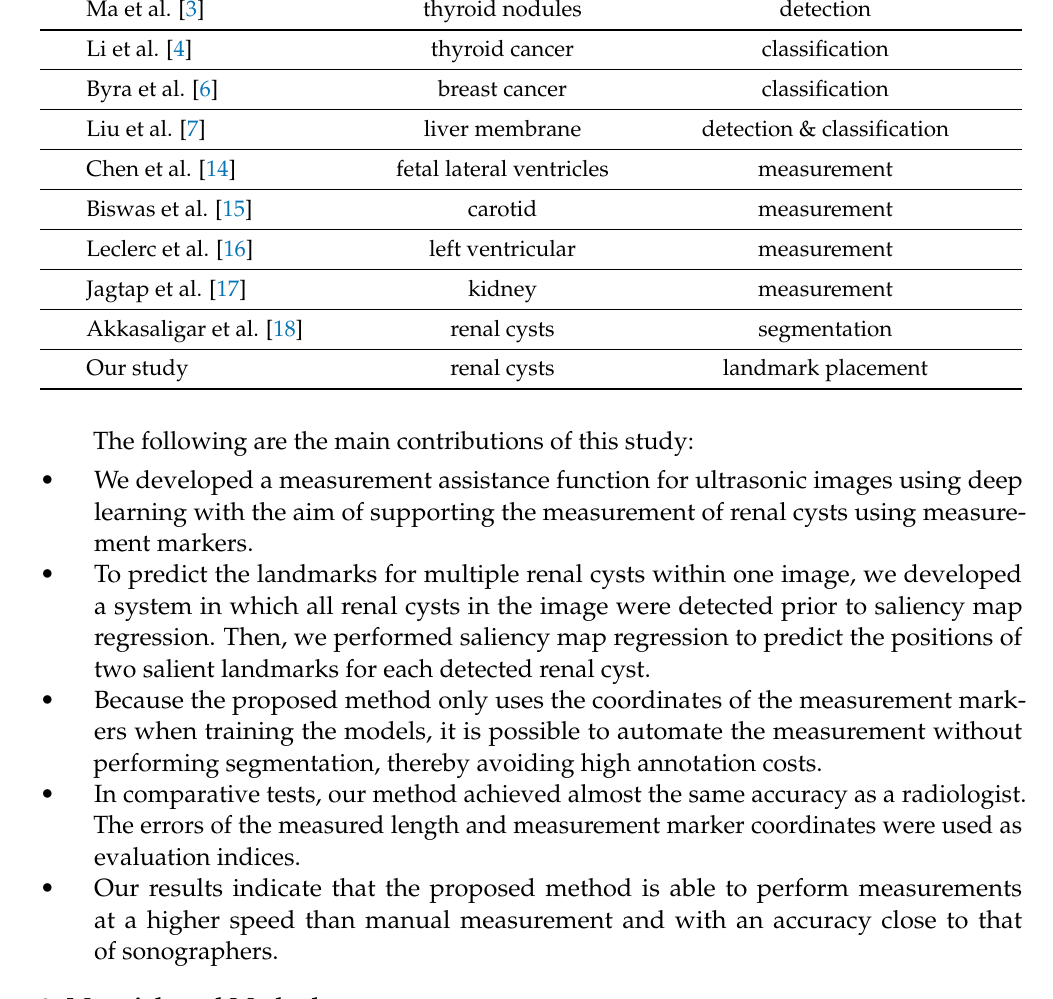
Table 1. Summary of related studies on deep learning-based analysis of ultrasound images. Study Object Task Ma et al. [3] thyroid nodules detection Li et al. [4] thyroid